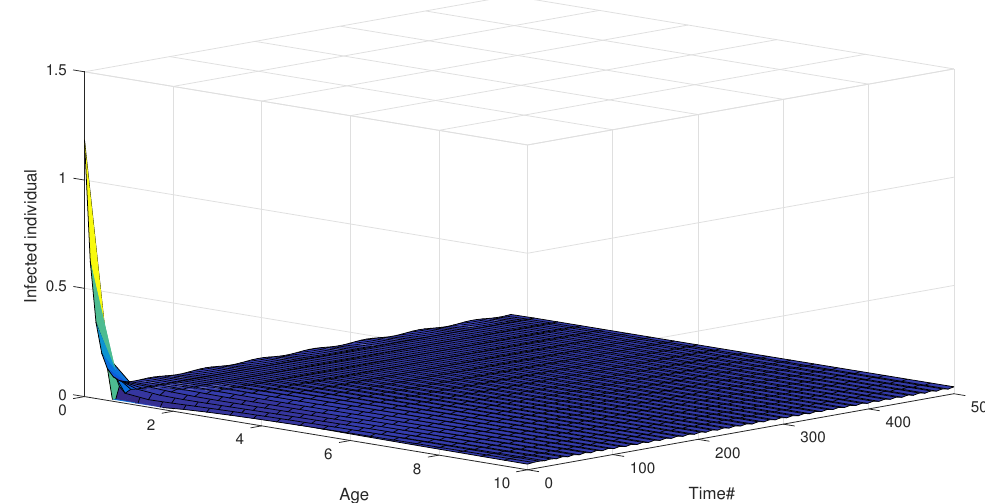
Figure 3. Age distributions of infected individuals with respect to time and acute stage (from 0 to 2 months) and chronic stage (from 2 to 10 months).